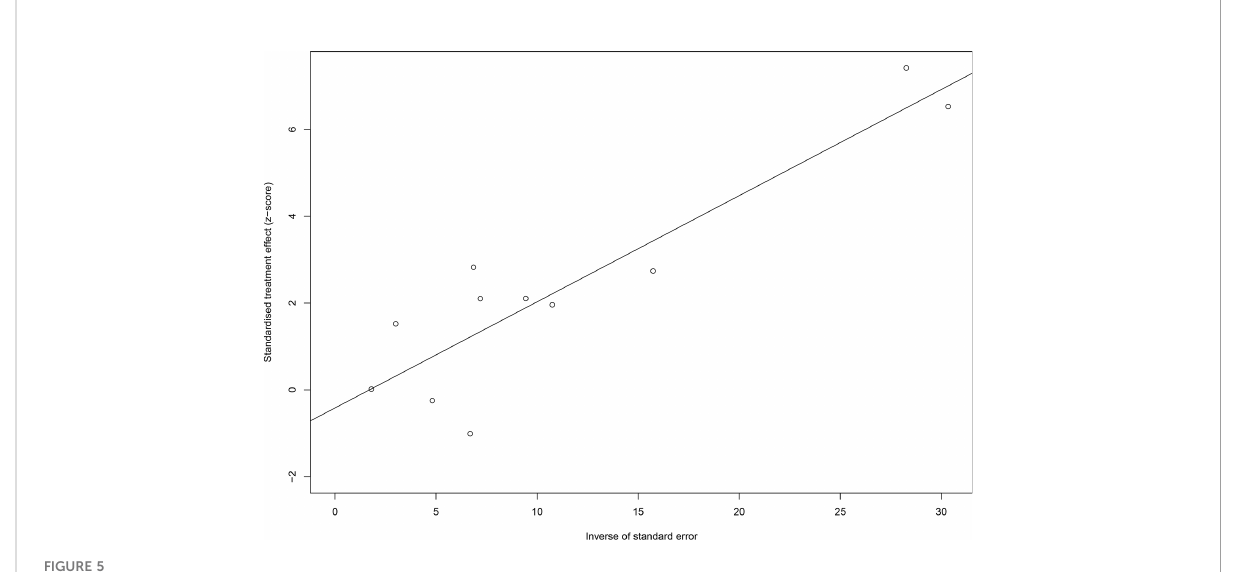
FIGURE 5 The result of Egger ’ s test.